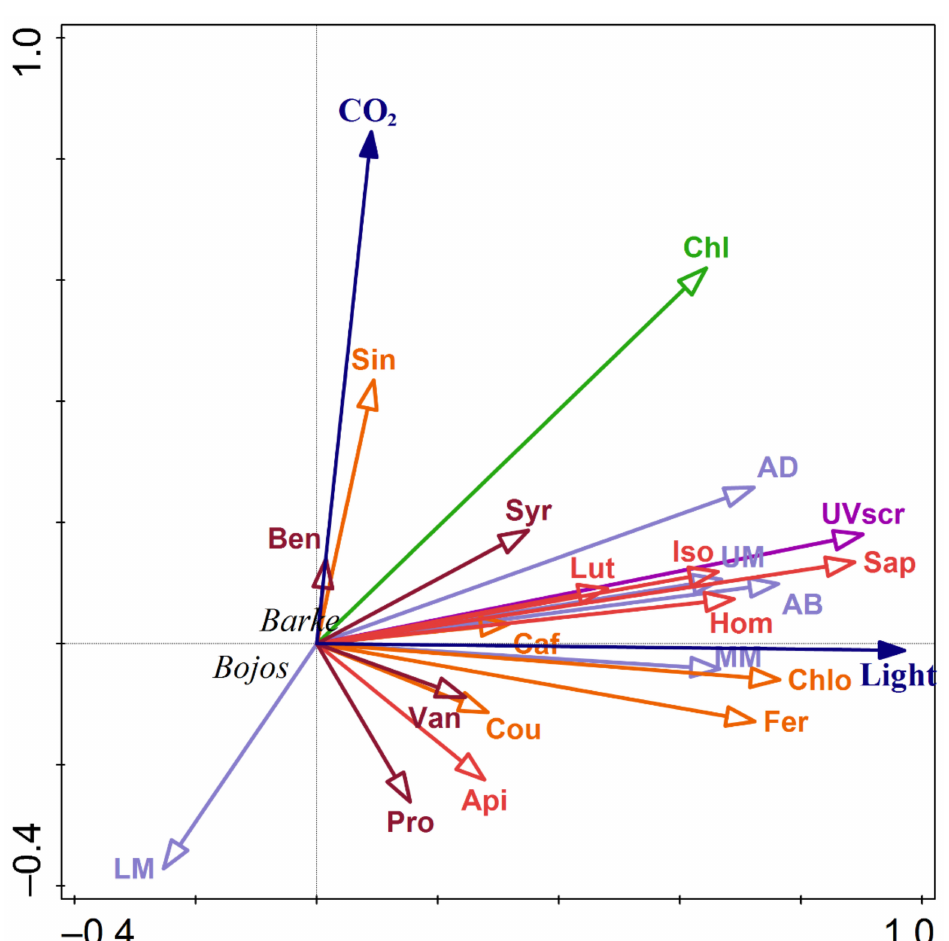
Figure 8. Biplot diagram representing results of redundancy analysis (RDA) on the effects of light intensity (Light), CO 2 concentration (CO 2 ), barley variety (Barke, Bojos) on the localization of PhCs within leaf cross-section (light purple; AD—adaxial mesophyll layer, UM—upper mesophyll, MM—middle mesophyll, LM—lower mesophyll and AB—abaxial mesophyll layer), content of hydroxycinnamic acids (orange; Cou—3-coumaric acid, Caf—caffeic acid, Fer—ferulic acid, Sin— sinapic acid, Chlo—chlorogenic acid), hydroxybenzoic acids (brown; Ben—3-hydroxybenzoic acid, Pro—protocatechuic acid, Van—vanillic acid, Syr—syringic acid), flavones (red; Api—apigenin, Lut—luteolin, Iso—isovitexin, Hom—homoorientin, Sap—saponarin), chlorophyll index (Chl) and UV screening of chlorophyll fluorescence (UVscr). Explained variation by axis 1 = 82.8% and cumulative explained variation by both axis = 91.6% (Pseudo-F = 25.9, p =